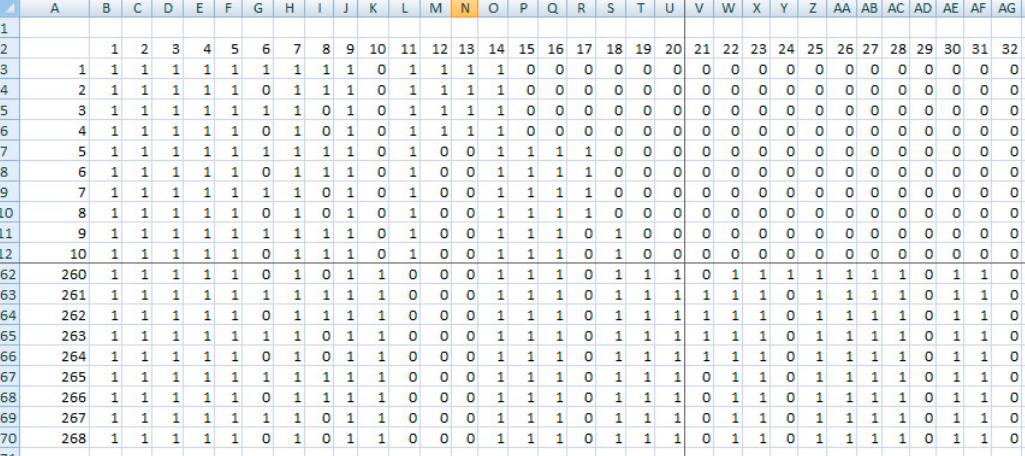
jects. Ward’s method is aimed at combining closely spaced clusters.